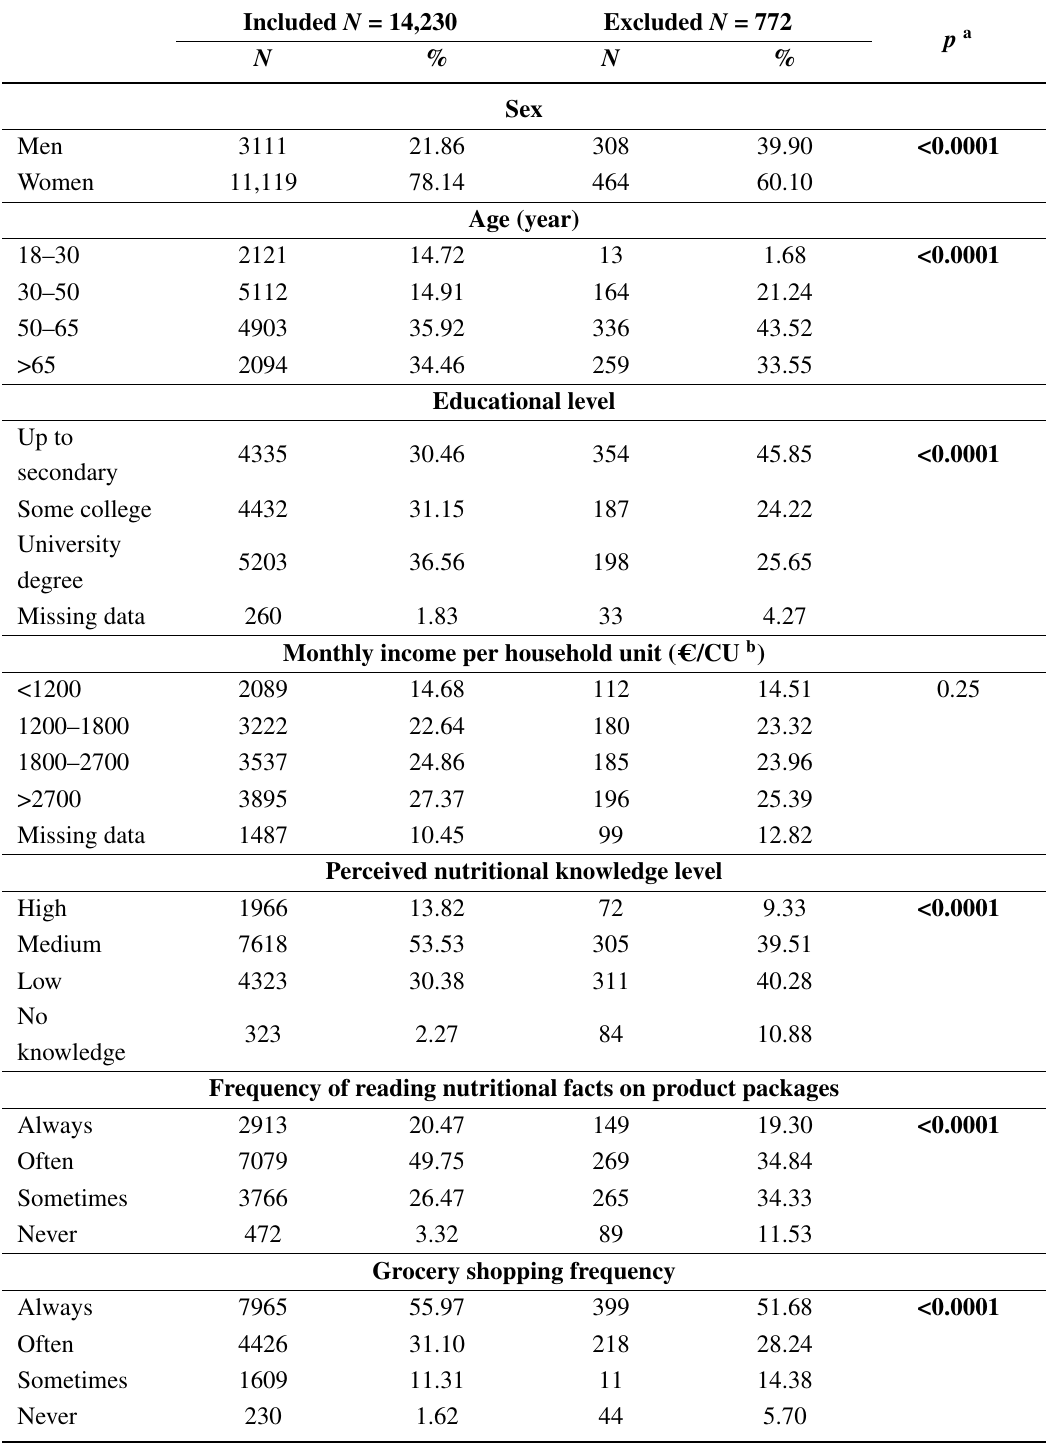
Table 1. Individual characteristics of included ( N = 14,230) and excluded ( N = 772)